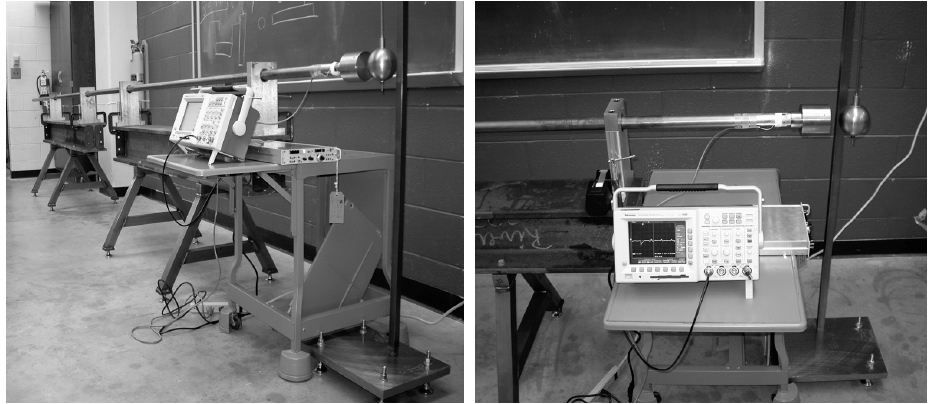
Fig. 4. The second experimental setup consisting of a Hopkinson bar and a ball